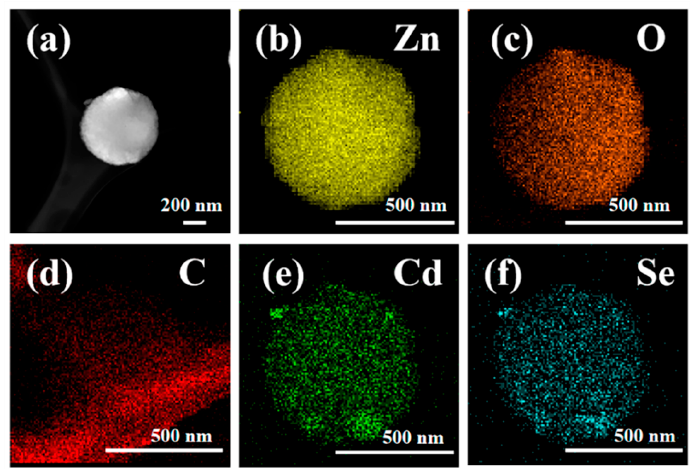
Figure 5. Element mapping of Z20CdSe–CC: ( a ) TEM image; ( b ) Zn, ( c ) O, ( d ) C, ( e ) Cd, and ( f ) Se. Most methods for preparing ZnO rods use Zn(NO 3)2 and HMTA, which were also used in this study [27,28]. In this study, Zn(NO 3)2 provided Zn 2+ , and HMTA acted as a nonpolar chelating agent to link Zn 2+ [29,30]. As shown in Figure 6, HMTA was a non- ionic cyclic tertiary amine that was hydrolyzed to produce NH 3 and HCHO, as shown